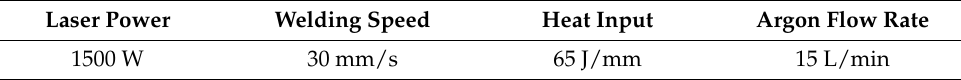
Table 2. Process parameter of laser welding for joining 2205 duplex stainless-steel. Laser Power